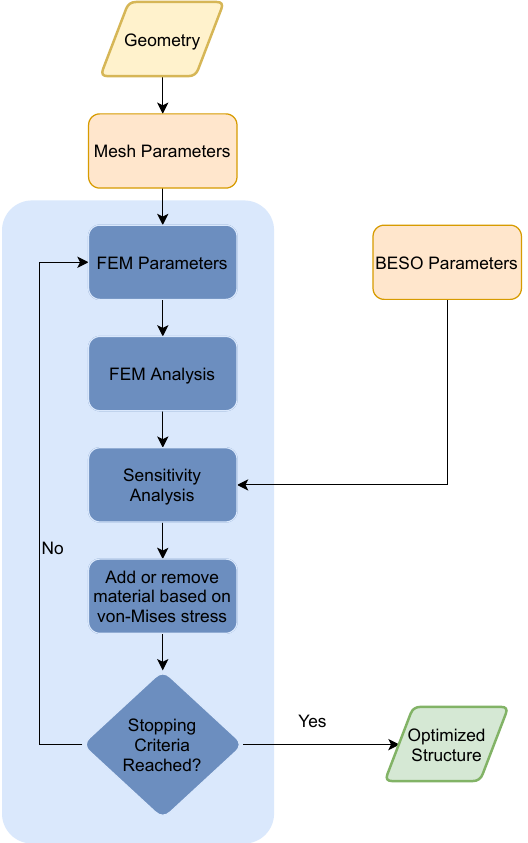
Figure 2. General algorithm for the BESO